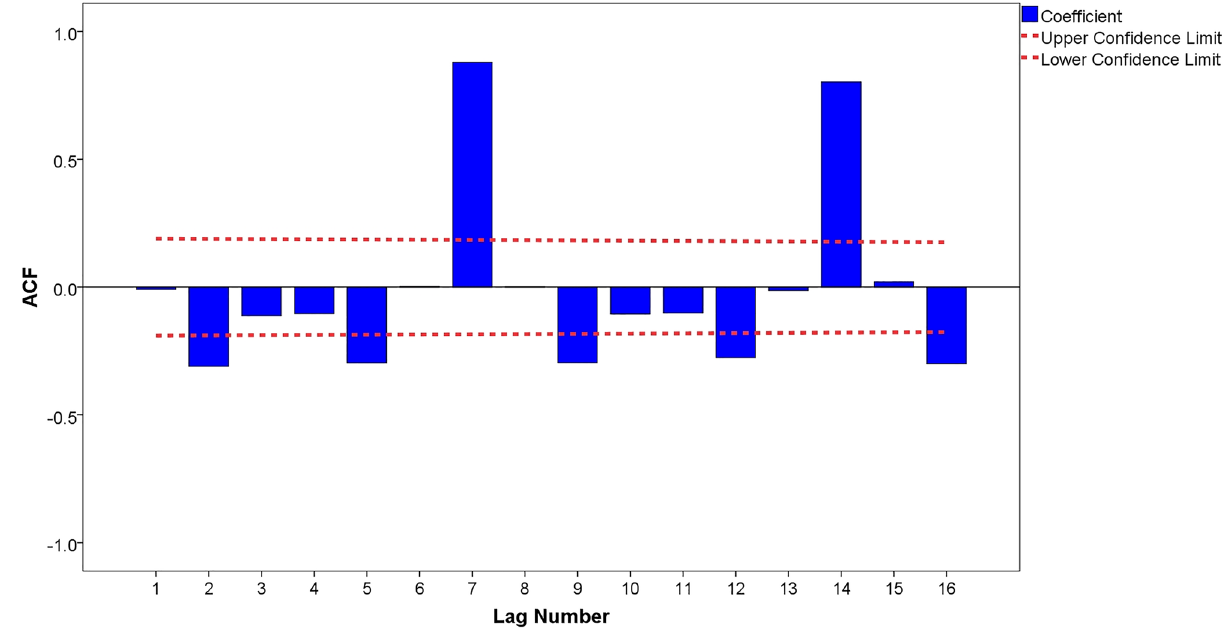
Figure.4. ACF chart of after the first-order difference and natural logarithm transformation.